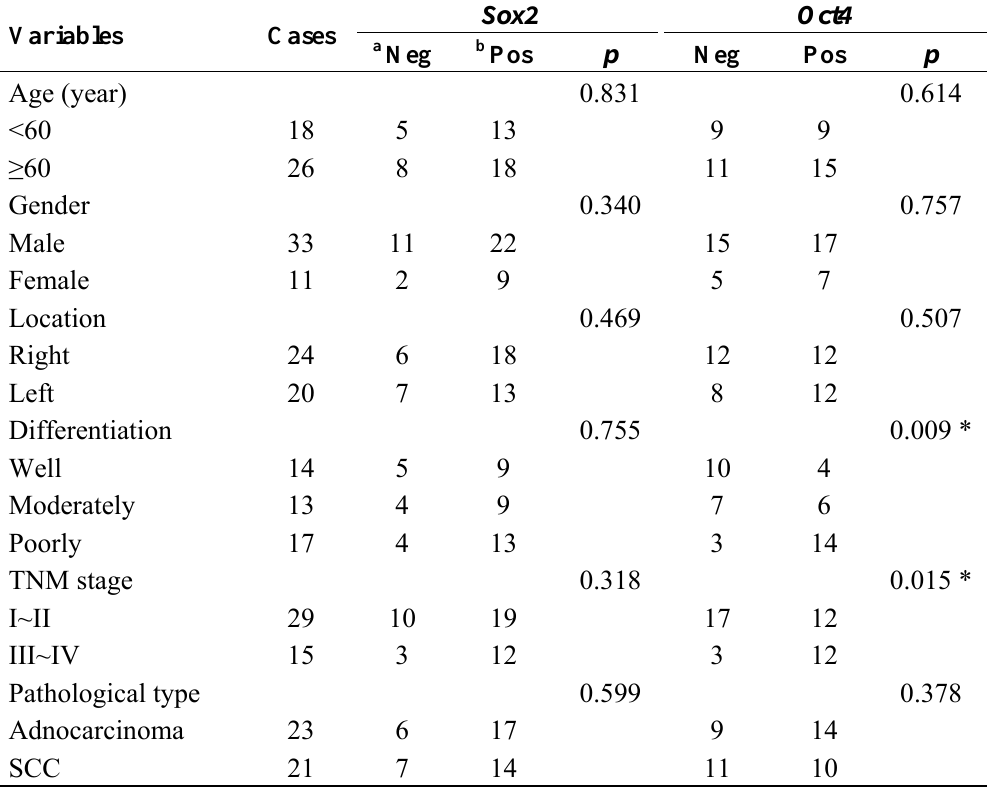
Table 2. Correlation of Sox2 and Oct4 expressions to clinicopathological features of non-small-cell lung cancer